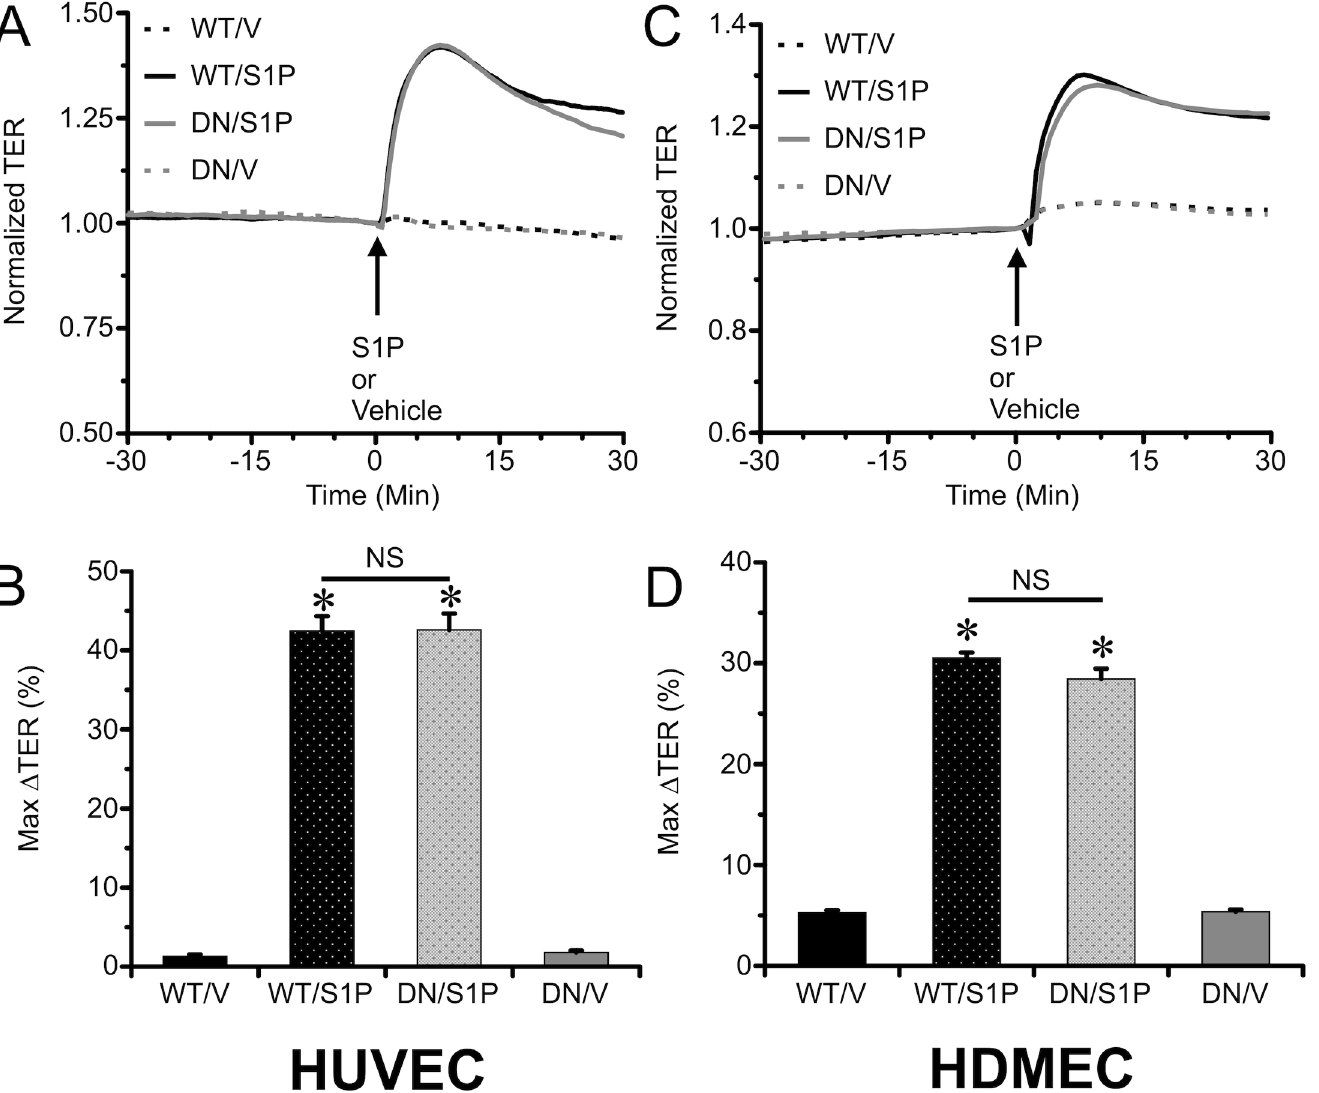
Fig 4. Overexpression of WT or DN Rac1 in HUVEC or HDMEC did not alter S1P-induced endothelial barrier enhancement. A . Time course of TER of HUVEC monolayers transfected with WT and DN Rac1 plasmids, treated with either 2 μ M S1P or vehicle (N = 8 each group). The TER is normalized to the time point just prior to addition of S1P for a more direct comparison of the magnitude of the response. B . The mean maximal change in TER (%) of HUVEC monolayers in the 10-min window immediately following S1P treatment. The corresponding data for HDMEC monolayers are shown in panels C & D (N = 8 each group). * P < 0.05 vs. Vehicle treated